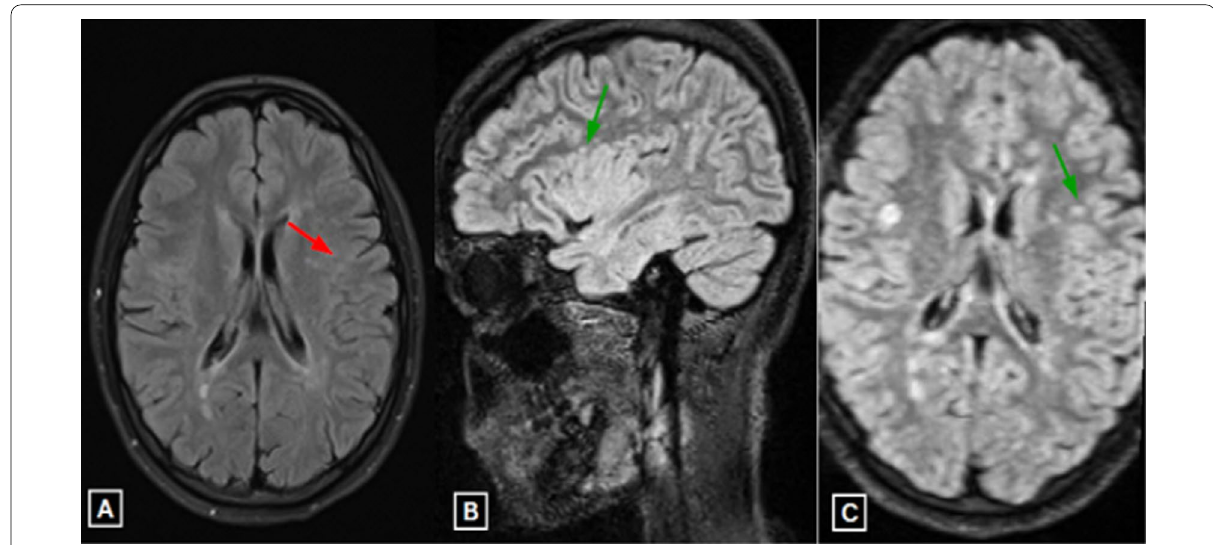
Fig. 5 Multiple scattered DWM lesions. Those are easily detected in MIP images (at C ) in comparison with axial 2D FLAIR (at A and B